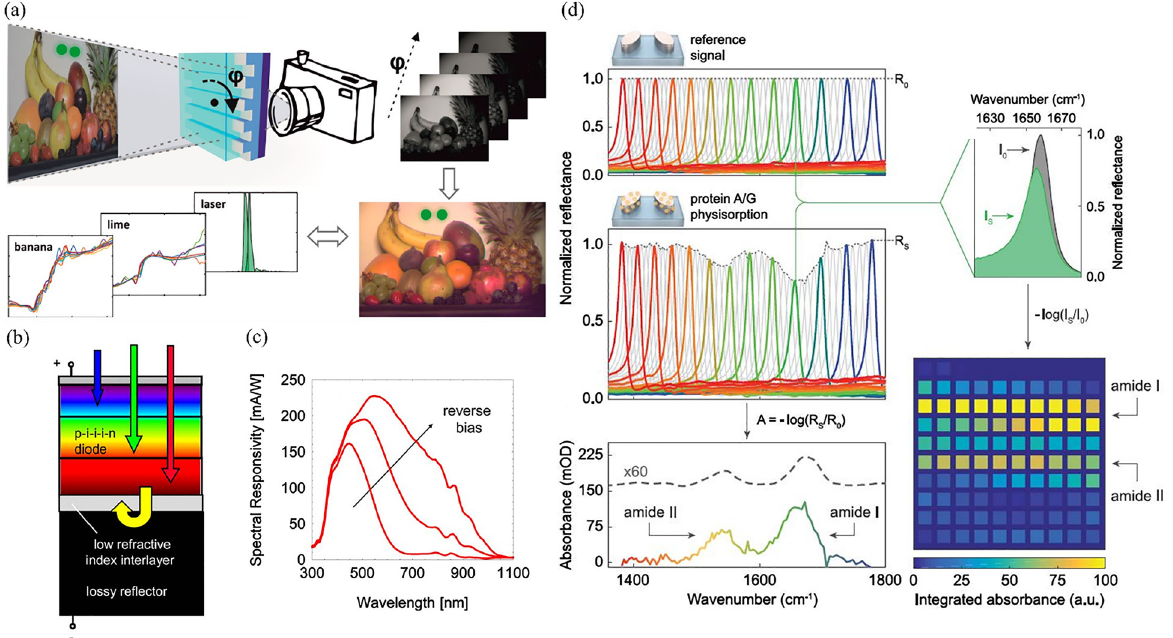
Figure 12: Standalone spectral filters for spectral imaging system. (a) Schematic of the setup for multispectral imaging using a tunable plasmonic-based color filter in front of an imaging camera. The filter property is tuned by polarization angle. Multispectral image and the spectra recorded at selected area are included at bottom part. (a) is adapted with permission from the study by Duempelmann et al. [28]. Copyright © 2017, American Chemical Society. (b) Cross section of vertically integrated tunable optical sensor. (c) Active tuning of sensor spectral responsivity by increasing reverse bias voltage. (b) – (c) are adapted with permission from the study by Jovanov et al. [125]. Copyright © 2018, American Chemical Society. (d) Protein absorptionspectral measurementandspatialmapping.Absorptionspectralisobtainedbytakingthedifferencebetweenthenormalizedre fl ectancespectralwith and without protein A/G. The spectral integration enables the translation from absorption signature into 2D absorption map as molecular barcode of protein (bottom right panel). (d) is adapted from the study by Tittl et al. [77]. Reprinted with permission from the translation from absorption signature into 2D absorp- tion map as molecular barcode of the biosample, as illus- trated in bottom right panel of Figure 12(d). A possible con fi guration to integrate the metasurface spectral fi lter with broadband IR detector array has also been provided in the study by Tittl et al. [77].